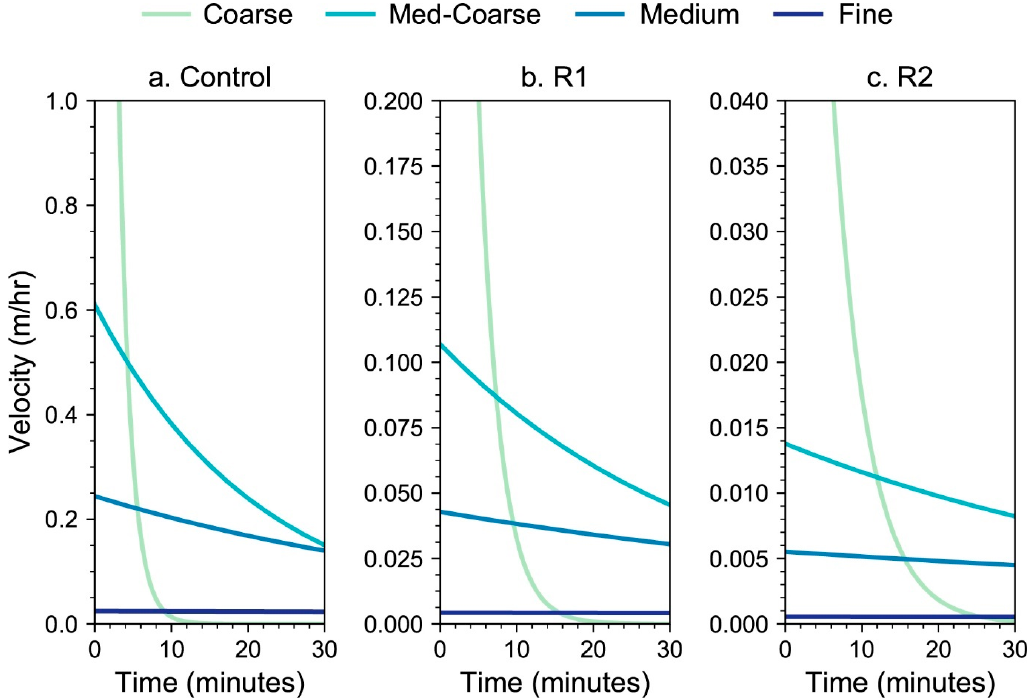
Figure 3. Modeled filter velocity vs. time at varying sand media for ( a ) a traditional BSF design (control); ( b ) a 40% reduced-height filter design (R1); and ( c ) a 70% reduced-height filter design (R2). Table 3. Modeled average filter velocity for each filter configuration (a traditional BSF design